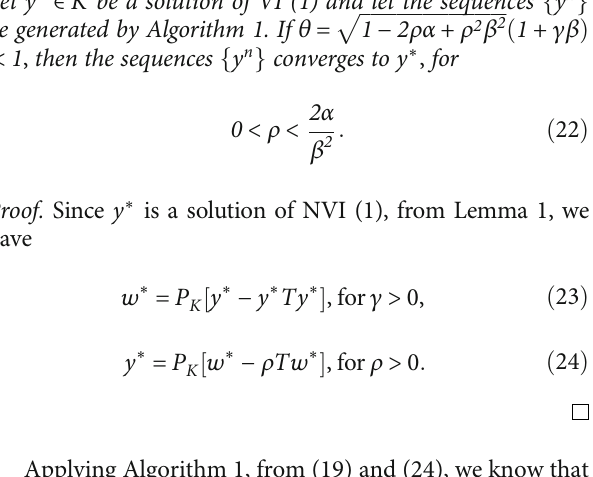
Algorithm 1. Step 1: Give ∈ >0, γ > 0, δ ∈ ð 0, 1 Þ , δ 0 ∈ ð 0, 1 Þ